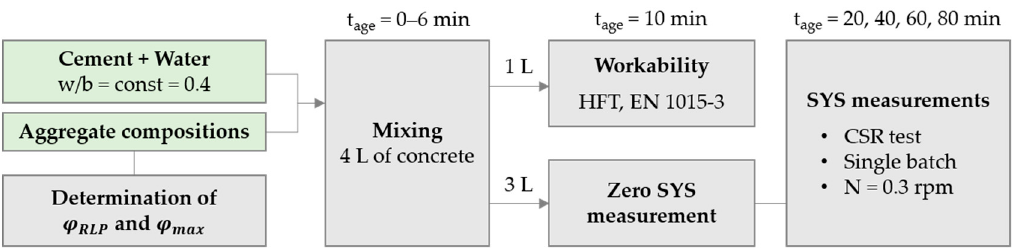
Figure 1. Summary of the experimental program.